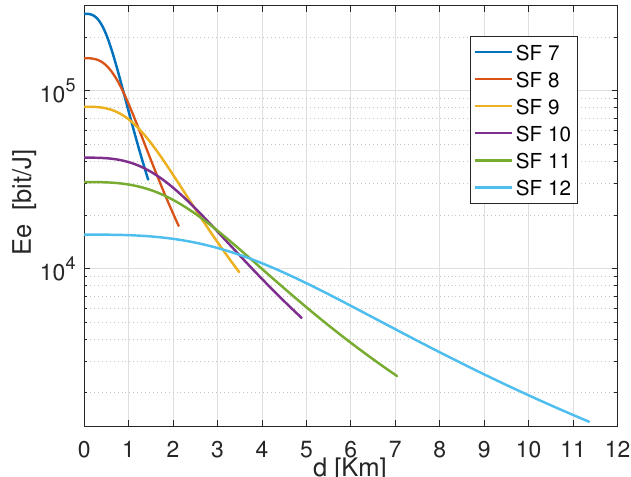
Figure 10. Energy efficiency distribution relative to variable covered distance d using different SFs with CR 4/8 to carry out a 30 Bytes